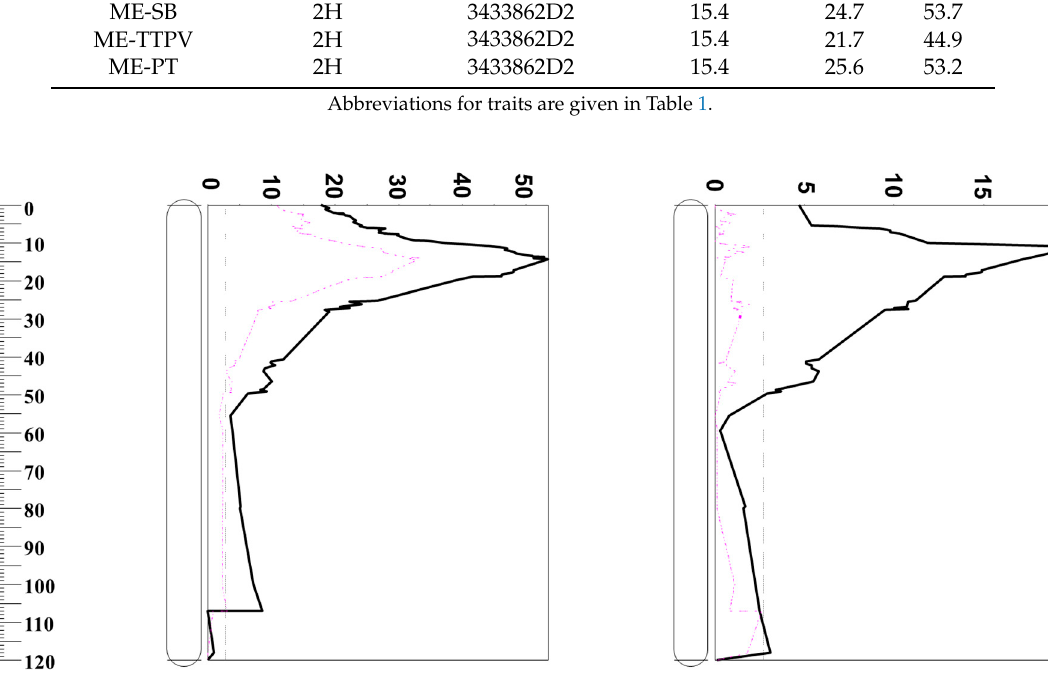
Figure 2. Percentages of phenotypic variation determined by QTL on 2H. Left : Malt extract with (red-dashed line) and without (black-solid line) breakdown as a covariate. Right : Breakdown with (red-dashed line) and without (black-solid line) malt extract as a covariate.